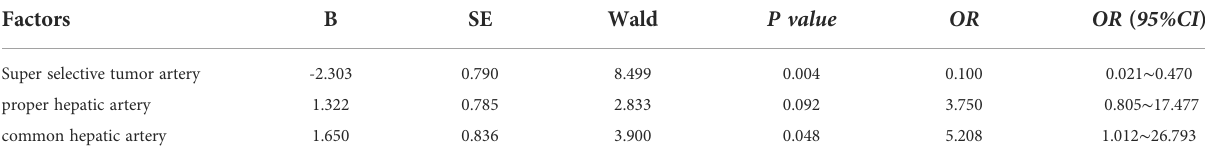
TABLE 7 Binary regression analysis of the relationship between the injection of Licartin into arteries and the decrease of the distribution of Licartin. Factors